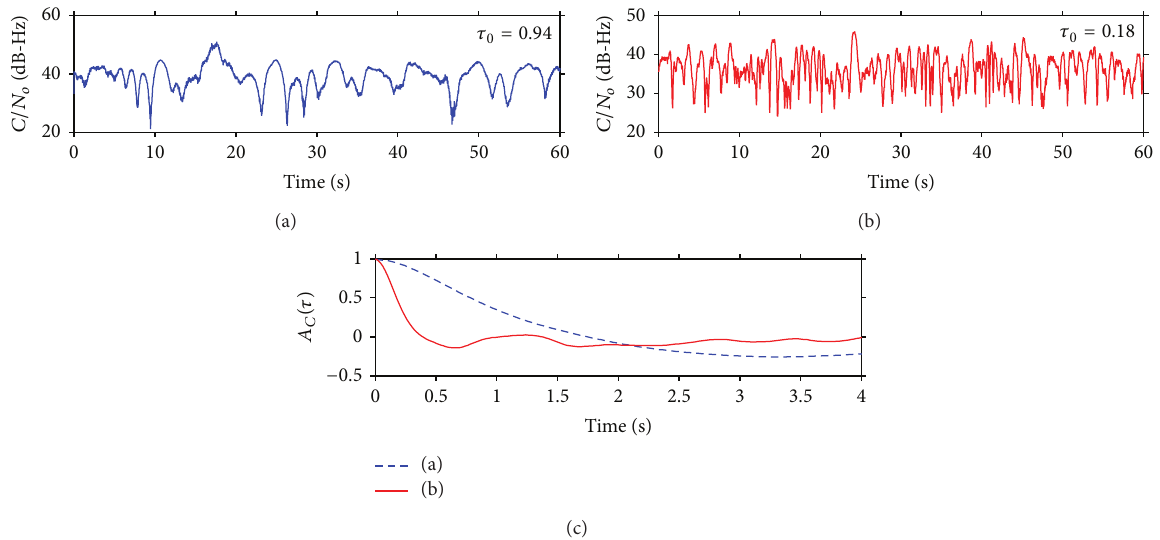
Figure 2: ((a) and (b)) Two examples of scintillation observations with 𝑆 4 = 0.9 but with different decorrelation times 𝜏 0 . (c) Autocorrelation coefficients for (a) and (b) cases,